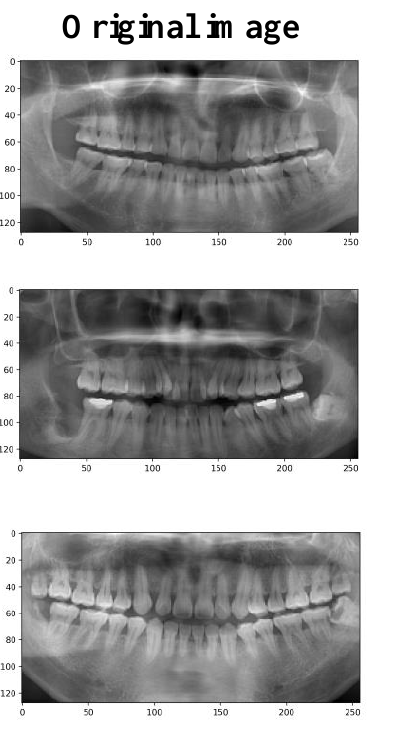
Figure 3. The reconstructed images by the autoencoder and the grad-cam heatmap. The brighter parts of the plots represent the areas that play a significant role in the model’s training phase.